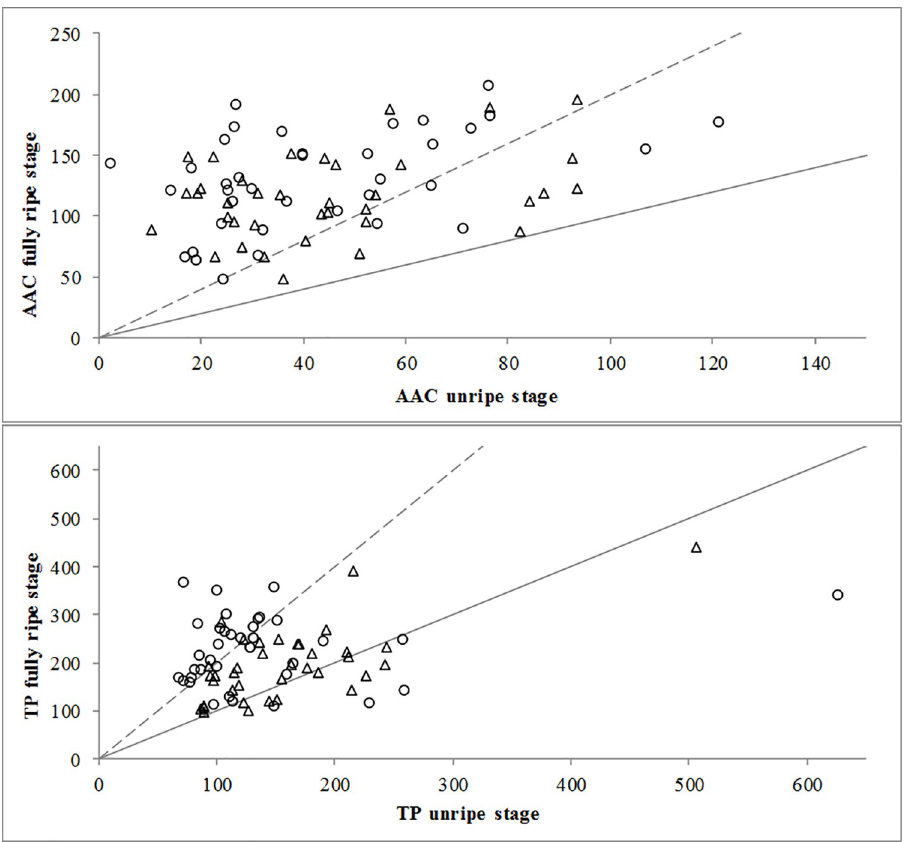
Fig 1. Comparative study of the content of ascorbic acid (AAC, upper, mg � 100 g -1 fresh weight) and total phenolics (TP, bottom, mg � 100 g -1 fresh weight), in organic ( � ) and conventional ( Δ ) growing systems. The oblique lines included in the graph represent slope 1 (continuous line, ratio fully ripe/unripe = 1, increase 0% with ripening) and slope 2 (discontinuous line, ratio TP fully ripe/TP unripe = 2, increase 100% with ripening).